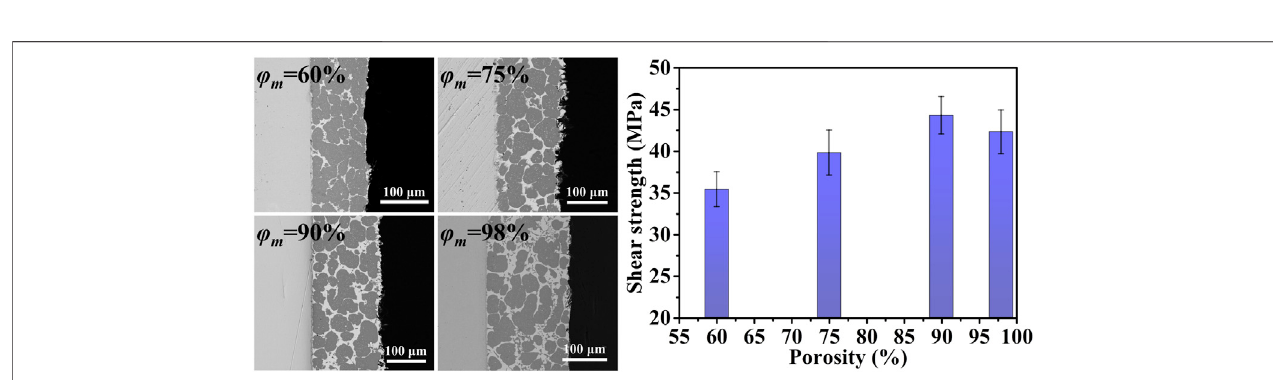
FIGURE 5 | SEM images and mechanical performance of C/C-Nb joints brazed using different G-Cu f interlayers differing in thickness.